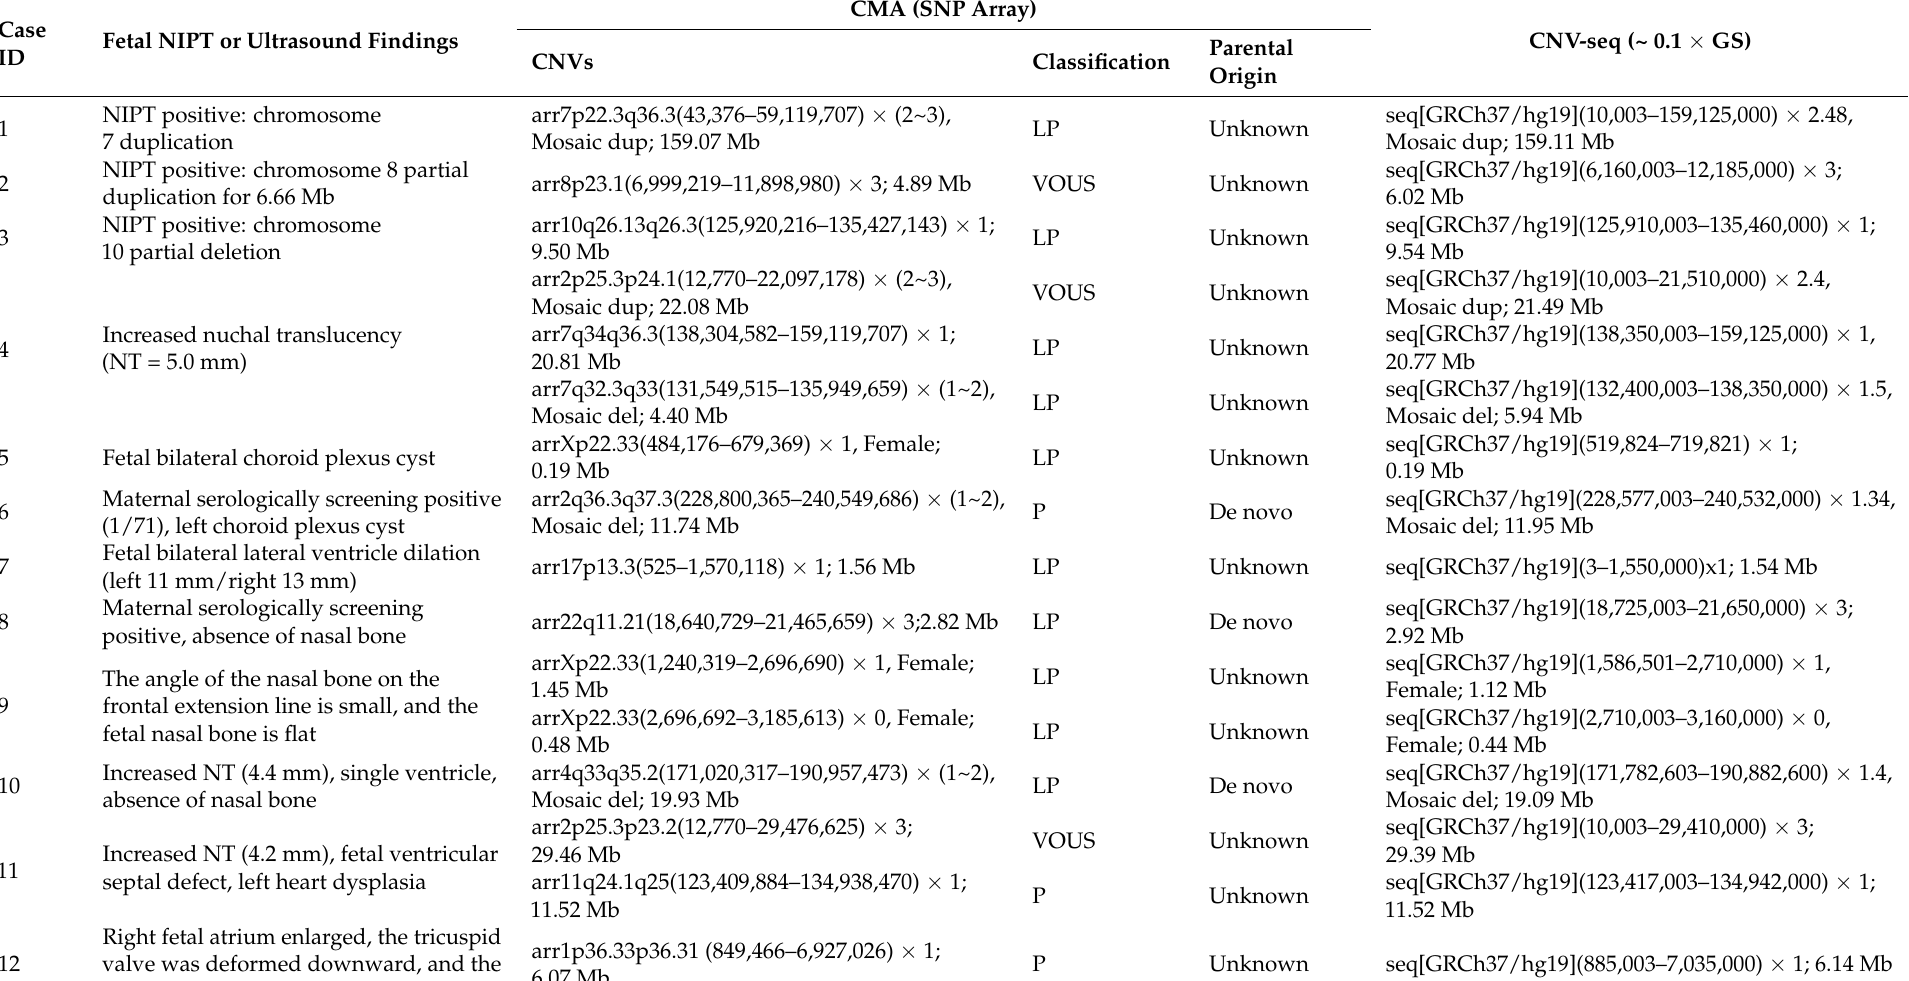
Table 1. Comparison of CNVs detected by CMA and CNV-seq in 20 prenatal